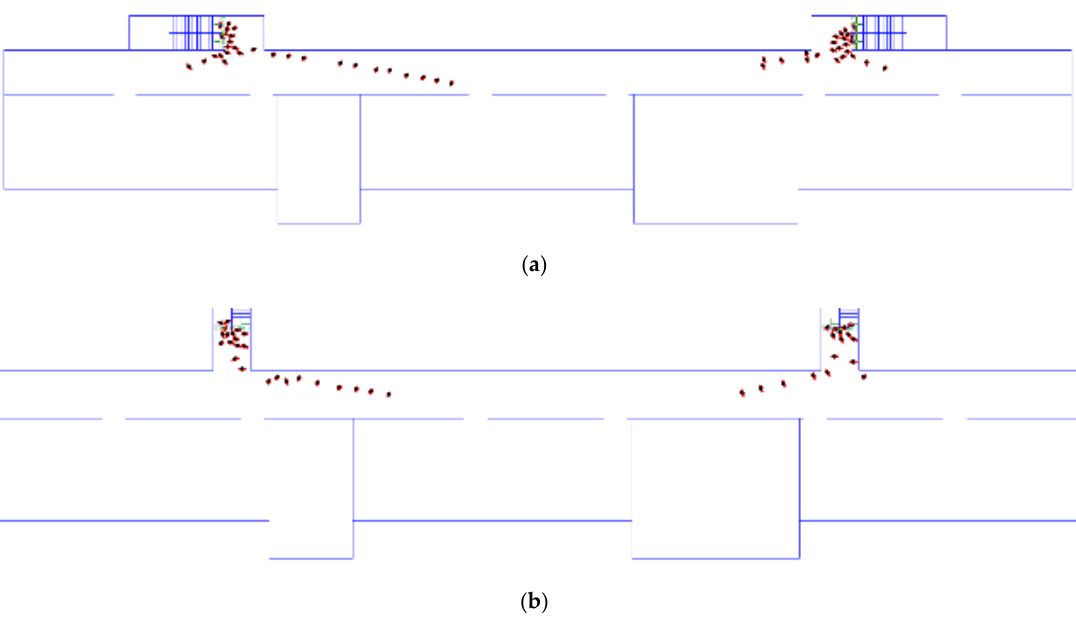
Figure 9. ( a ) Parallel, 1.2 m; ( b ) vertical, 1.2 m.